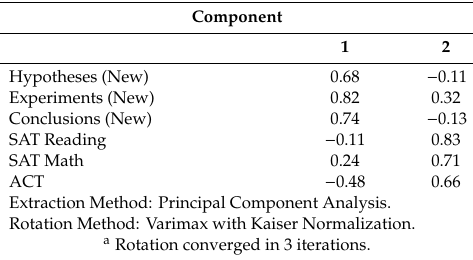
Table 5. Study 1. Rotated principal-component matrix: New measures plus college-admissions tests ( g- based) a .